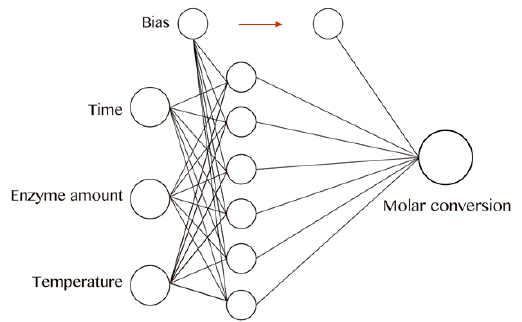
Catalysts 2017 , 7 , 342 Figure 3. The illustration of multilayer feed ‐ forward neural network. The neural network having three inputs of variables (reaction temperature, reaction time, and enzyme amount), one hidden layer with six neurons (nodes) and one output of response (molar conversion of 2 ‐ ethylhexyl salicylate).